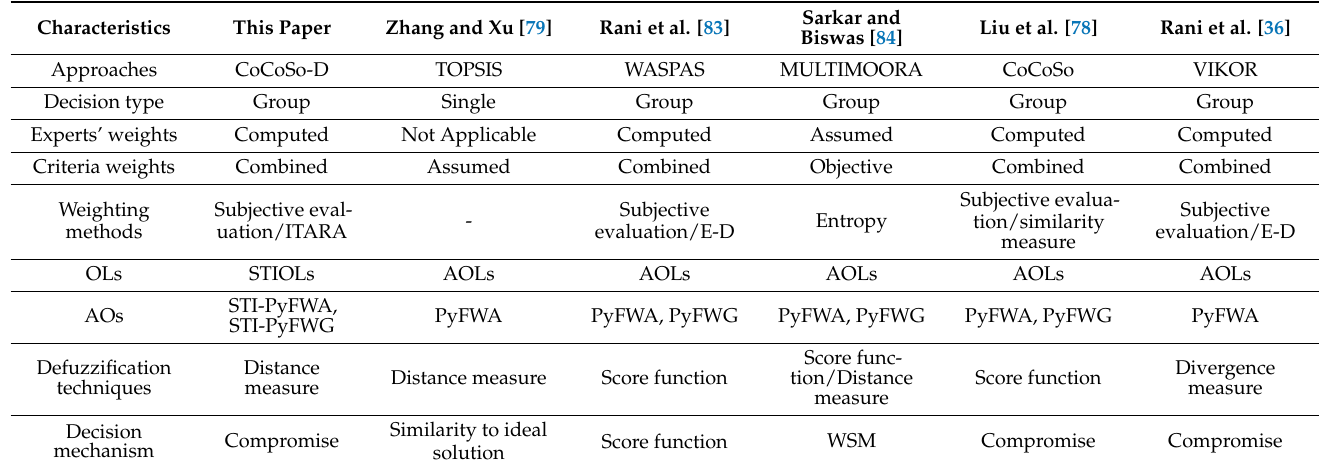
Table 13. Comparison with different